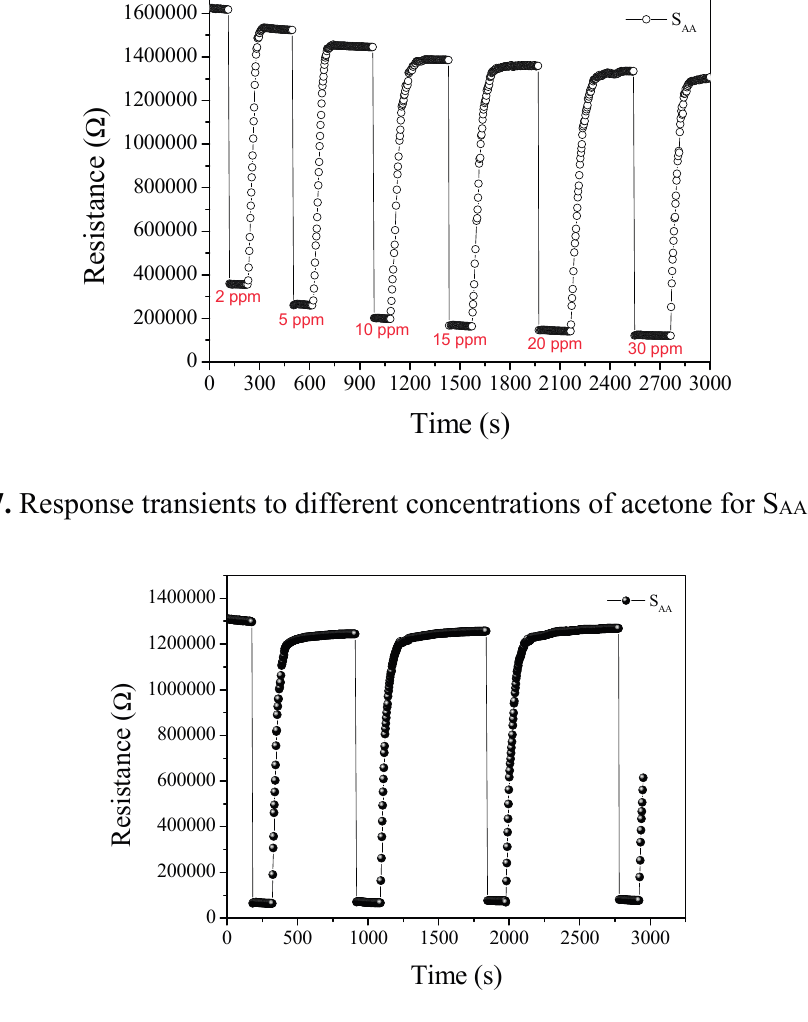
Figure 8. Repetitive response and recovery of S AA to 100 ppm acetone gas at 250